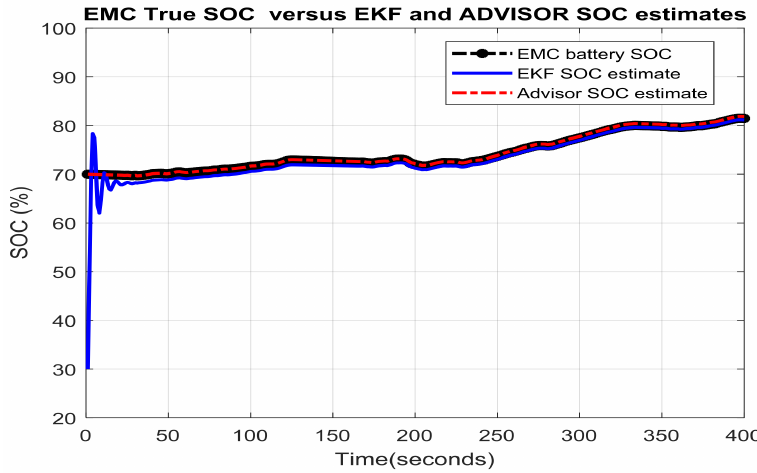
Figure 24. The 3RC EMC SOC model versus EKF SOC and ADVISOR SOC estimates for T = 10 ◦ C.